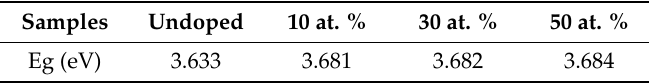
Figure 4. ( a ) Reflectance spectra of SnO 2 and FTO NPs; ( b ) Plot of ( α h ν ) 2 versus photon energy ( h ν ) of SnO 2 and FTO NPs. Table 2. The optical band gap of SnO 2 and FTO NPs.